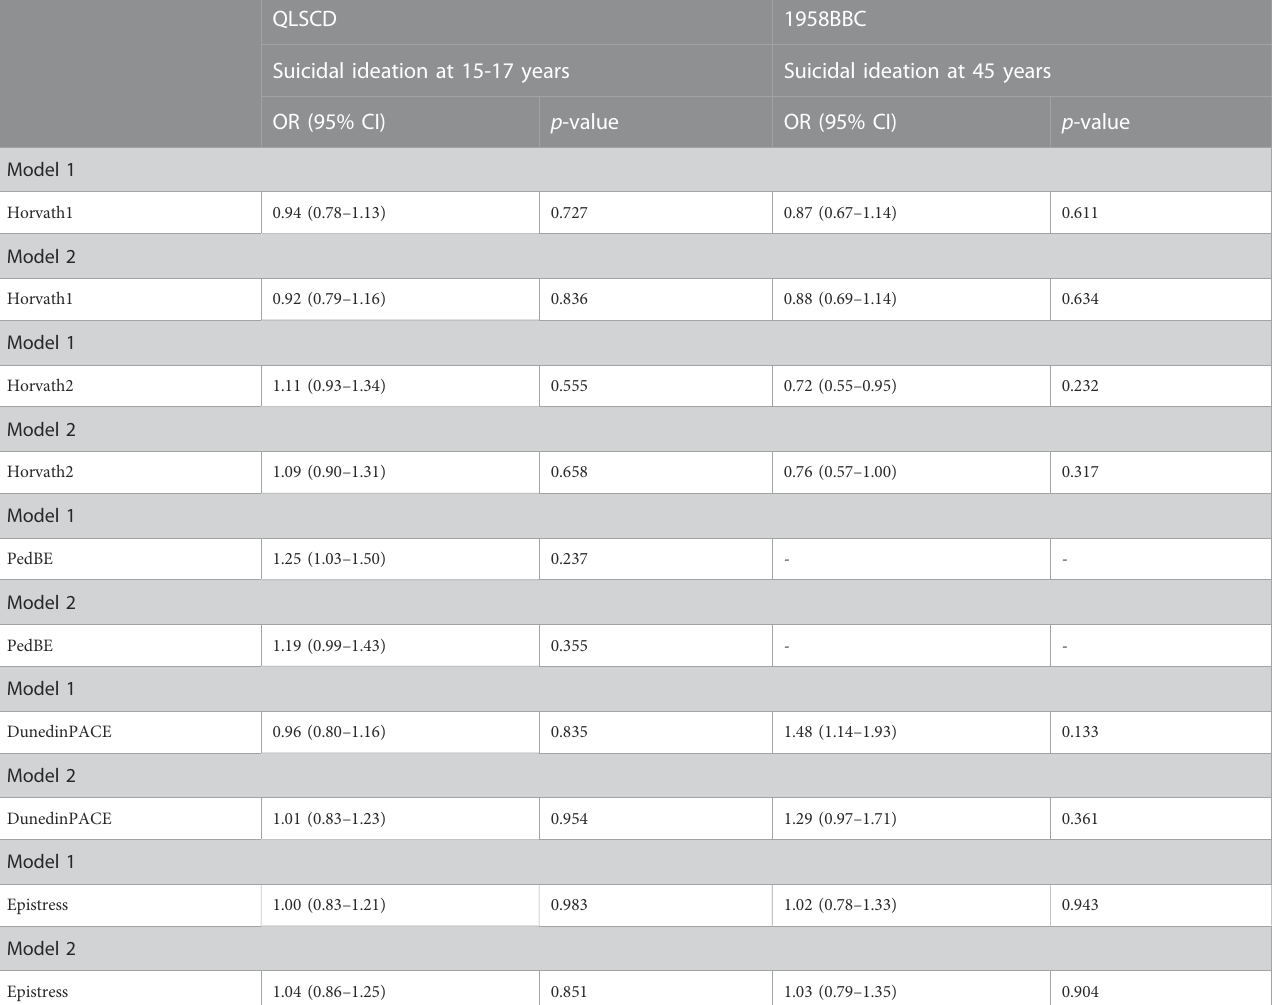
TABLE 5 Logistical regressions between epigenetic residuals and suicidal